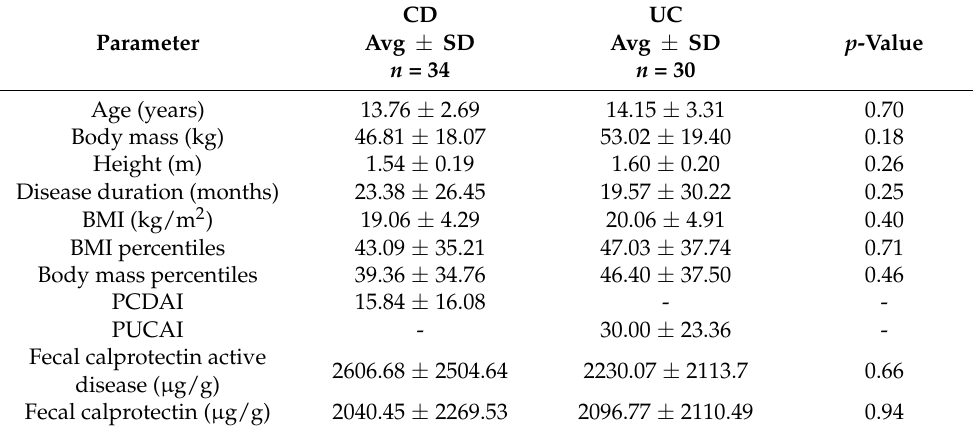
Table 1. Characteristics of patients with CD and UC.